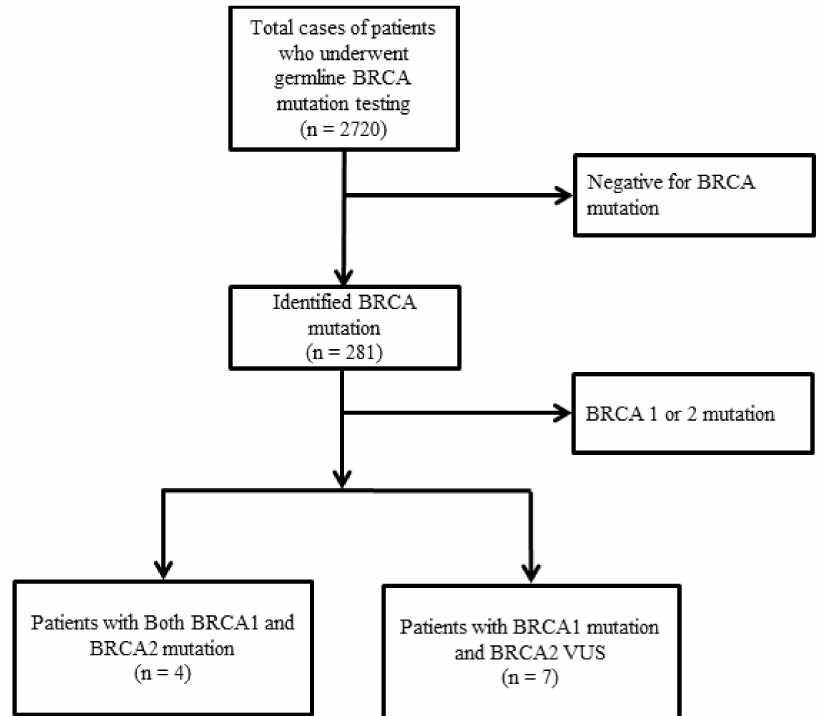
Figure 1. Flow chart of patient selection. Among a total of 2720 patients, four patients with both germline breast cancer susceptibility genes (gBRCA) 1 and 2 mutations were identified (4 / 2720; 0.14%). There were seven patients with gBRCA1 mutation and gBRCA2 variants of unknown significance (VUS), but no patients with gBRCA2 mutation and gBRCA1 VUS. BRCA, breast cancer susceptibility genes; VUS, variant of uncertain